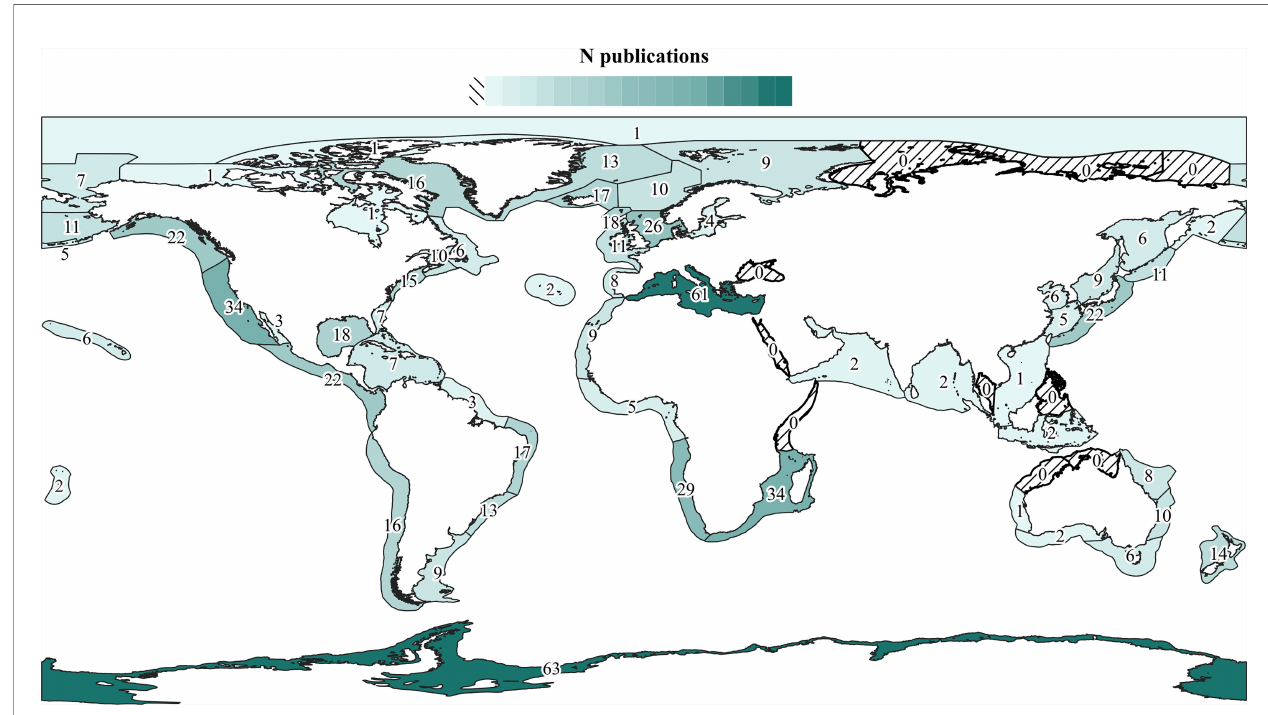
FIGURE 4 | Number of publications (indicated by numbers and color gradient) on cetaceans that contain data on their epibiotic fauna at least to genus level grouped by Large Marine Ecosystems (LME). When the same publication includes data for several LMEs, it is counted separately for each one. Azores (NE Atlantic) and Tonga (SW Paci fi c) are not in the LME system but were included as additional